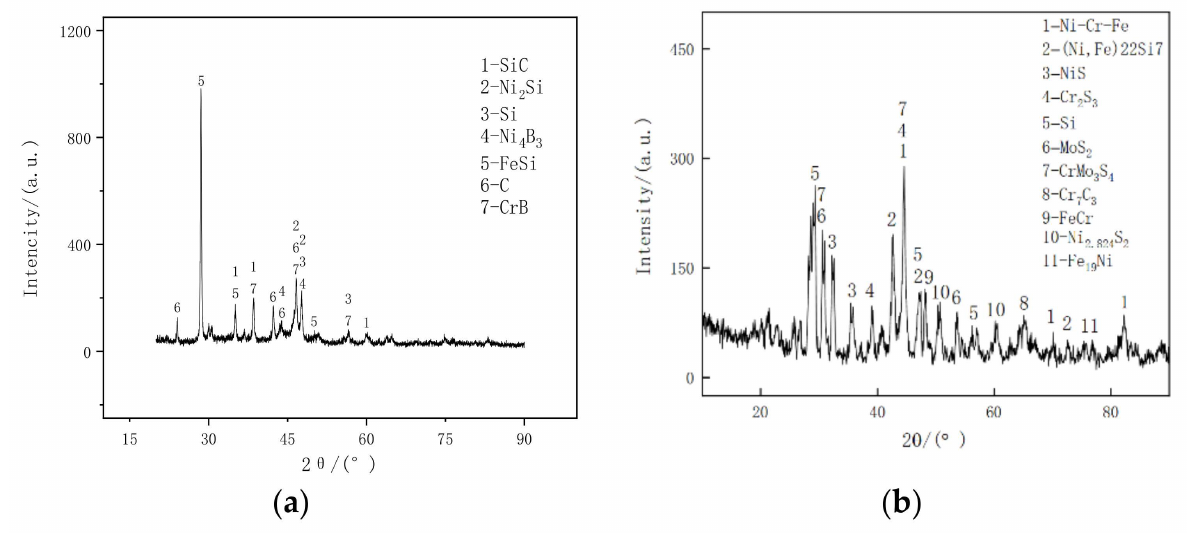
Figure 5. XRD pattern of ( a ) Ni35 + 20% SiC, ( b ) Ni35 + 20% SiC + 20% Ni/MoS 2